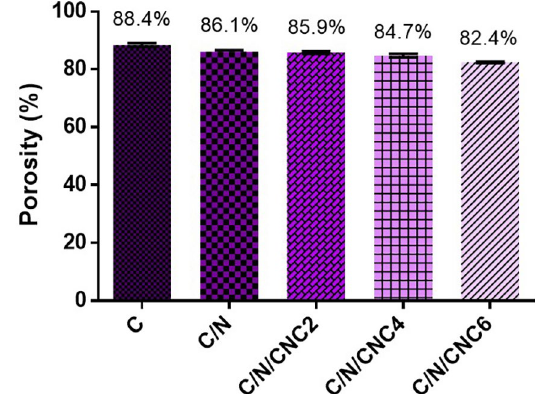
Figure 5. Porosity values of the hydrogels obtained by X-Ray microtomography. Results are given as mean ± SD (n =